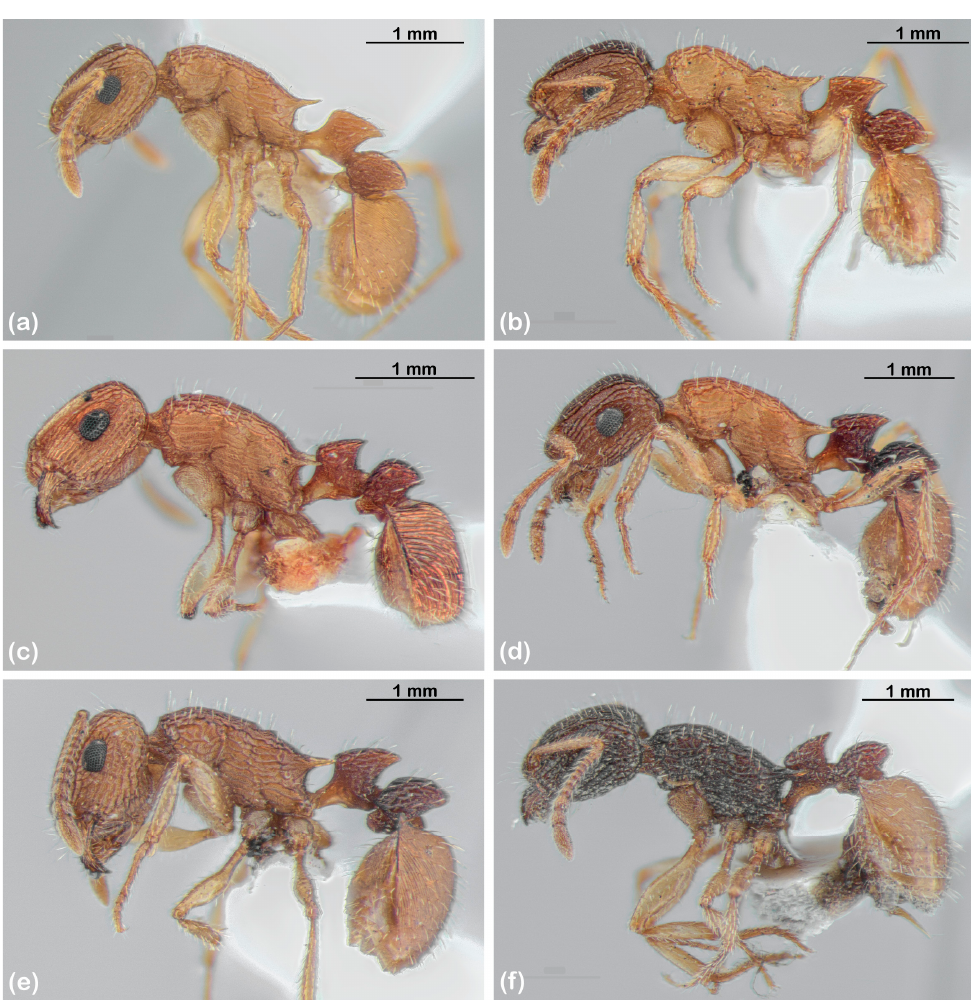
Figure 5. Variation in morphology, sculpture and colour among species of the T . spininode group. 5 ( a ) sp. 12; King River, NT (not sequenced); ( b ) sp. 8; nr Manyallaluk, NT (not sequenced); ( c ) sp. 6; Manbulloo Stn, NT (not sequenced); ( d ) sp. 9; nr Beswick, NT (not sequenced); ( e ) sp. 11; OZBOL 3950-21; ( f ) sp. 26; TET